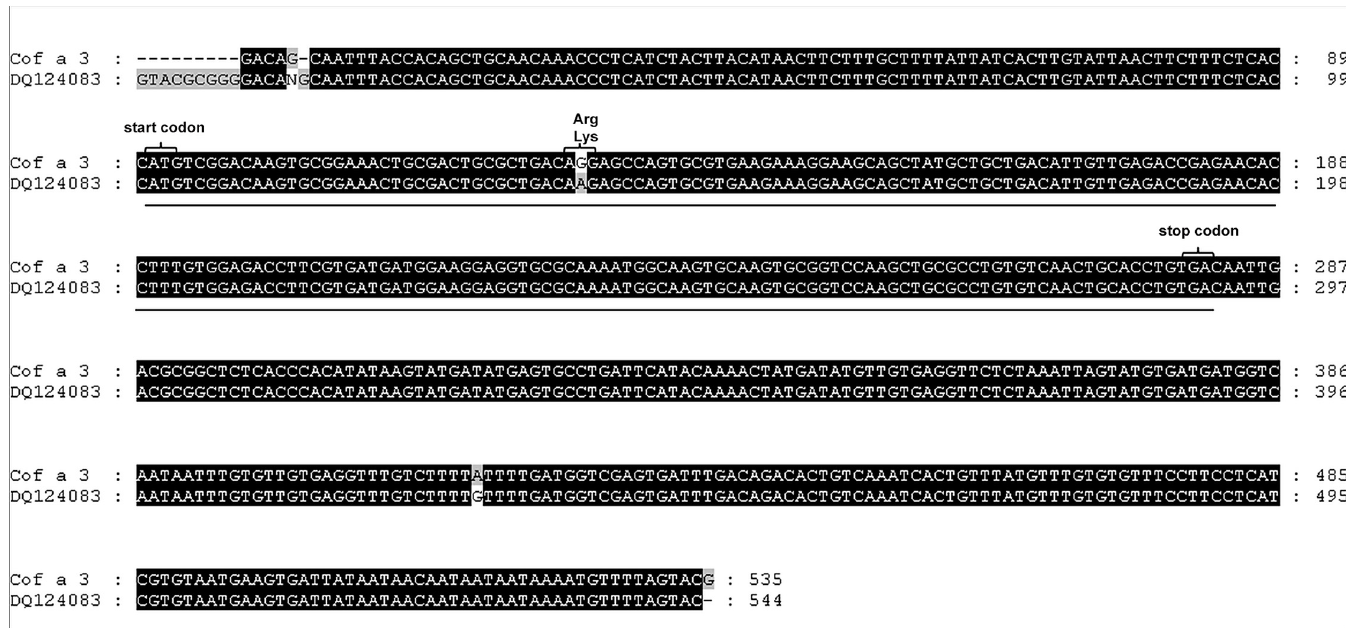
Fig 2. Sequence alignement of Cof a3 cDNA clone and its homologue NCBI DQ 124083. Homologous regions to the known coffee metallothionein described by Guzzo et al. 14 are highlighted in black. In position 138 and 426 of the protein forming open reading frame a polymorphism in the cDNA sequence is seen (underlined), in position 137 – 139 there is one single polymorphism in the amino acid sequence.